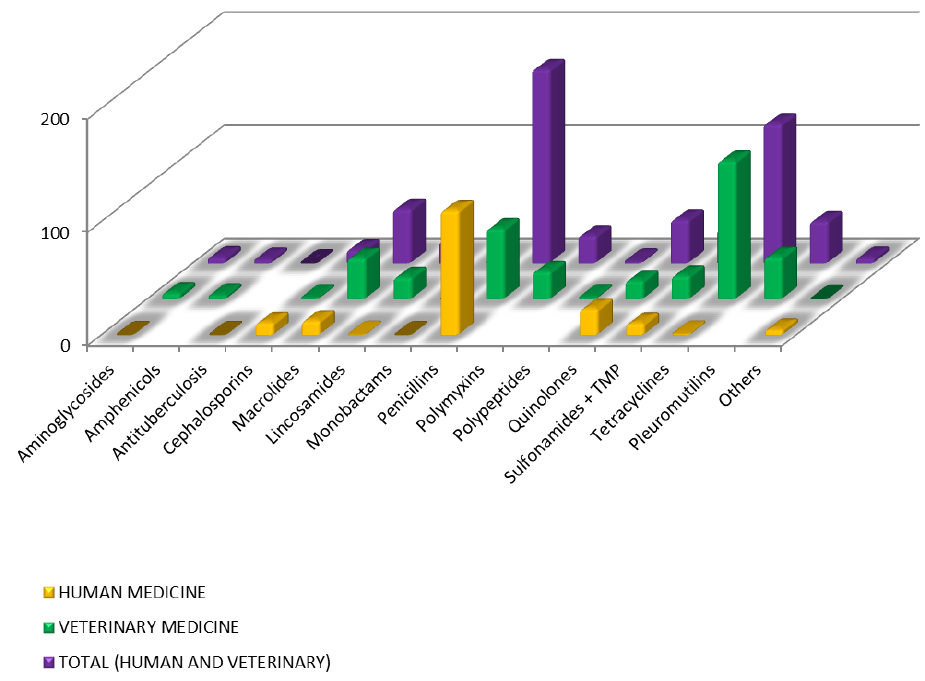
Figure 1. Comparison between antibiotics consumption in both human (orange) and veterinary (green) medicine in the two years under study and the total consumption taking into account both practices (purple) (TMP, trimethoprim).